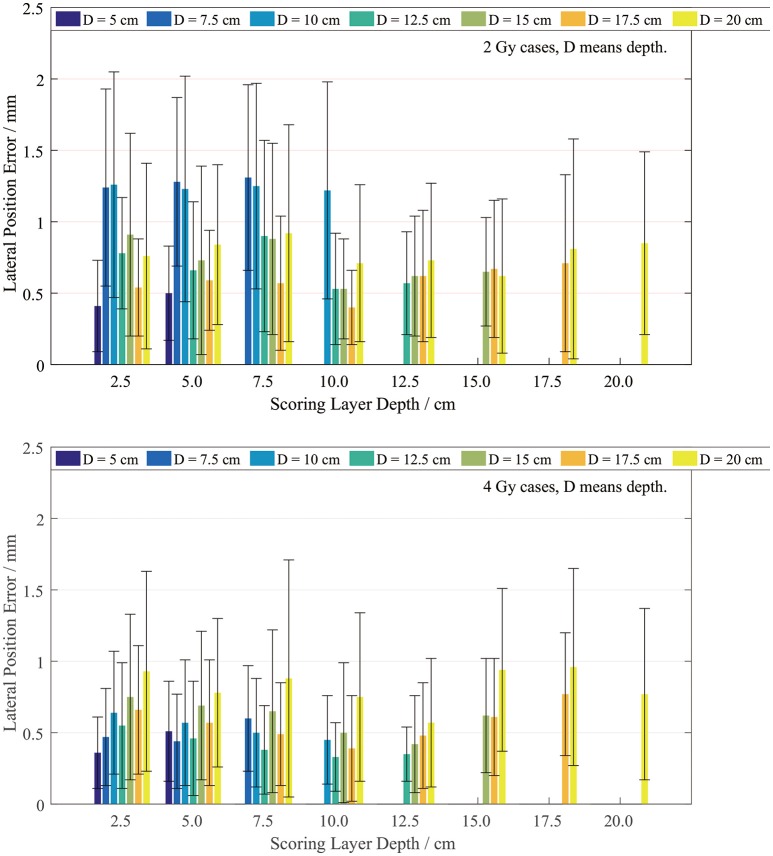
Lateral errors for the 2 Gy (top) and 4 Gy (bottom) cases with different depths.